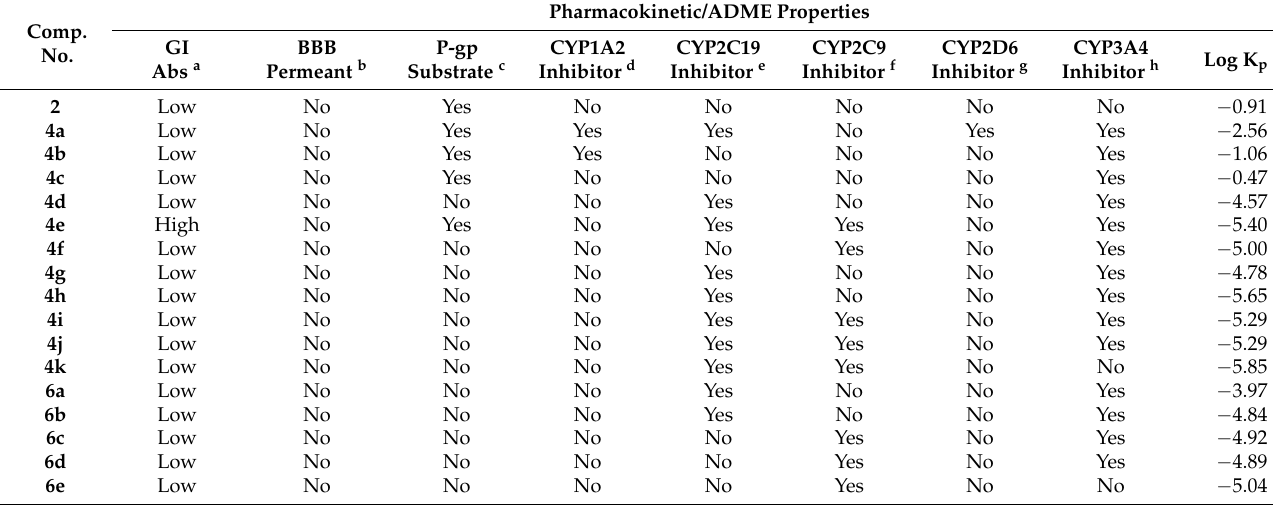
Table 3. Pharmacokinetic/adsorption, distribution, metabolism, excretion, and toxicity (ADME) properties of the selected compounds. Comp.